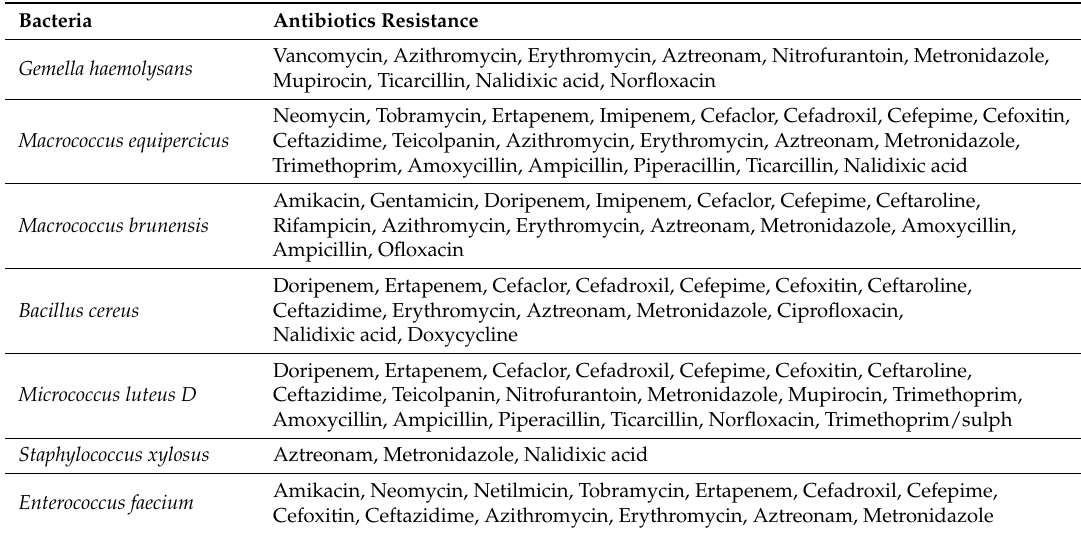
Table 7. Antibiotic resistance pattern on disk diffusion